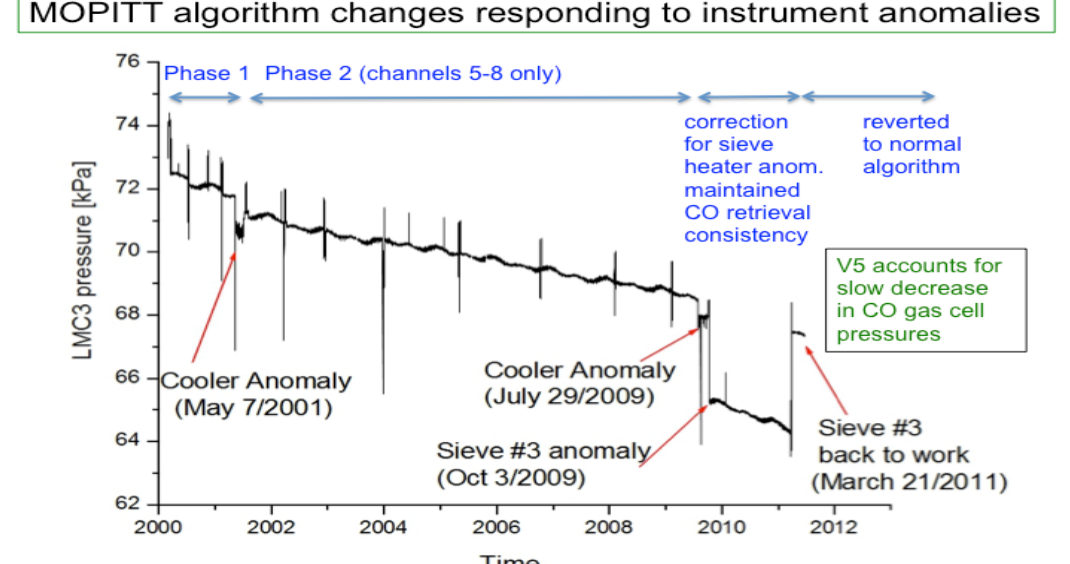
Figure 2. MOPITT pressure vs. time since launch for LMC3. The pressure change is slow (~ 5% in 10 years). Phase I represents MOPITT data with both optical benches operational; Phase II, after the cooler anomaly in May, 2001 uses only 1 optical bench. A transient molecular sieve heater fault in 2009 lowered the sieve temperature and pressure dropped ~6%, but corrections in L1 and L2 algorithms maintained data continuity and quality until normal operations were resumed on the restart in 2011. The spikes correspond to decontamination and calibration operations. The current trend is about 1% pressure loss per year. (Courtesy of F. Nichitiu, U.